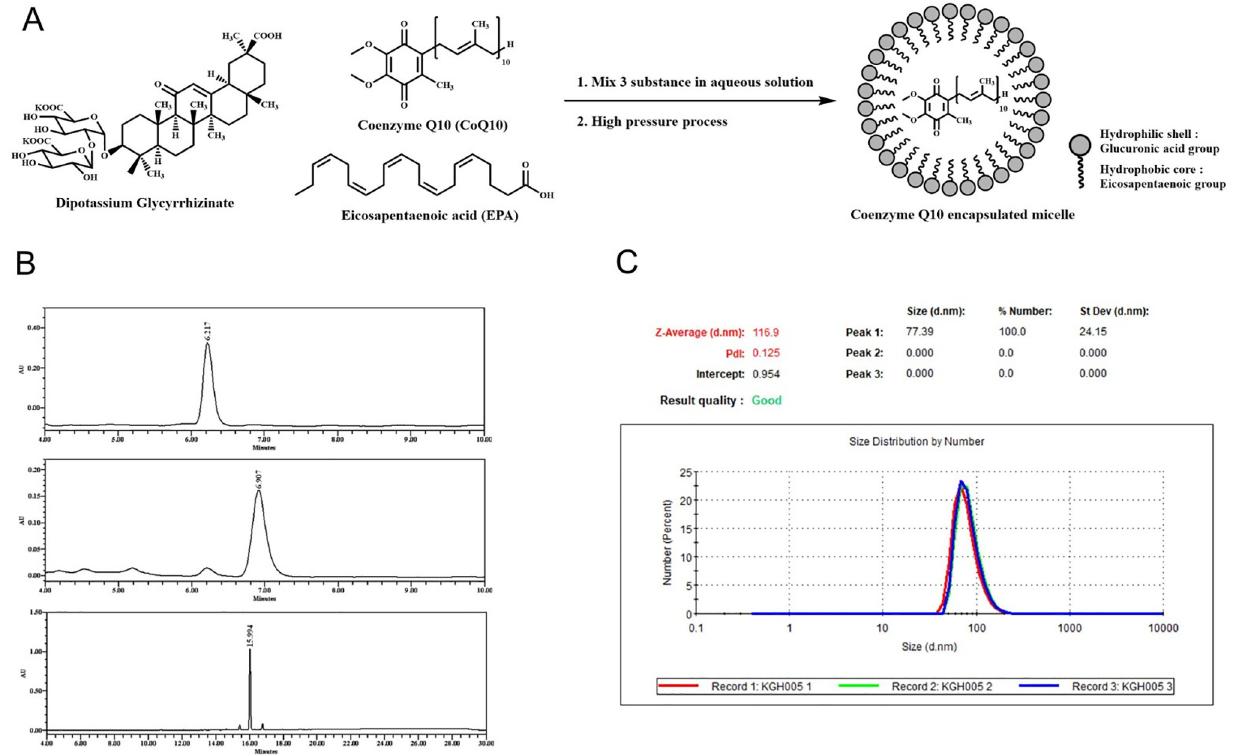
Fig 1. Preparation of encapsulated CoQ10. (A) Schematic showing preparation of CoQ10-micelles. (B) The HPLC profile of the nanoemulsion: EPA (top), CoQ10 (middle), and dipotassium glycyrrhizinate (bottom). (C) Nanoemulsion particle size distribution as revealed by dynamic light scattering